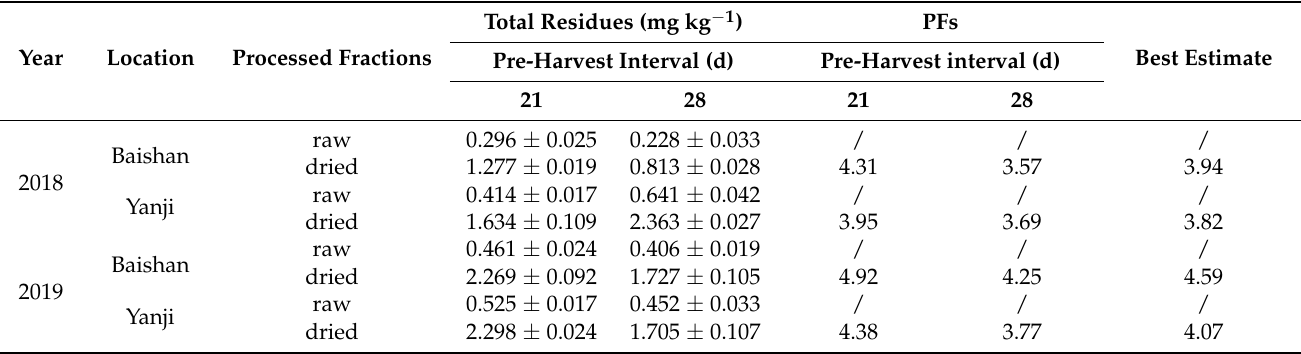
Table 2. Effect of processing on flupyradifurone residues in